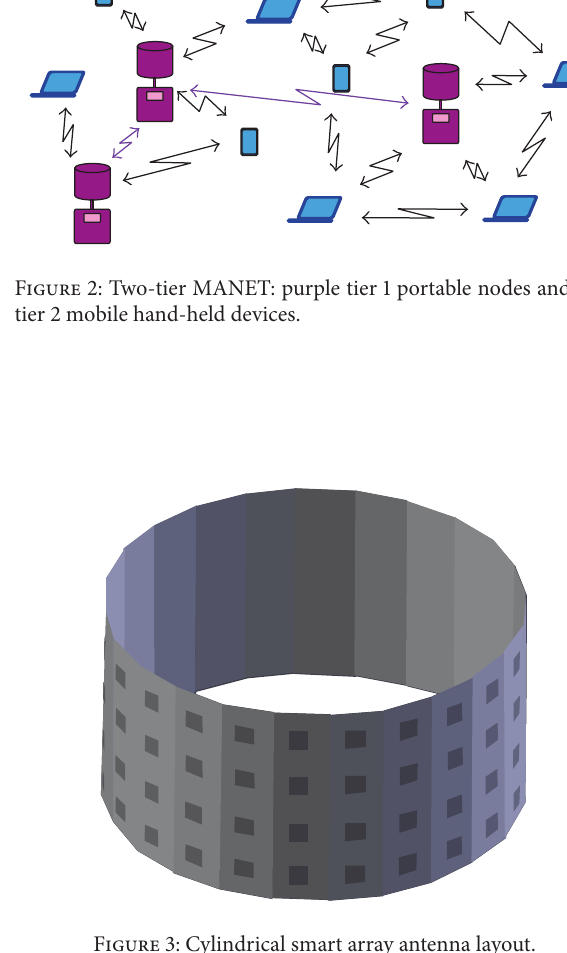
Figure 3: Cylindrical smart array antenna